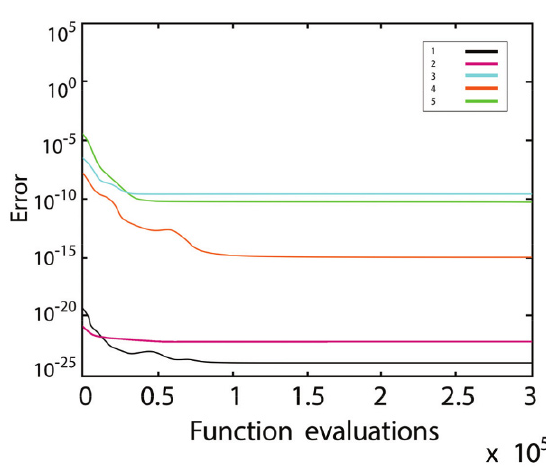
Figure 10. TheresultsofapplyingtheMSCAon F 1 – F 5 (Convergence of Functions F 1 – F 5 ).